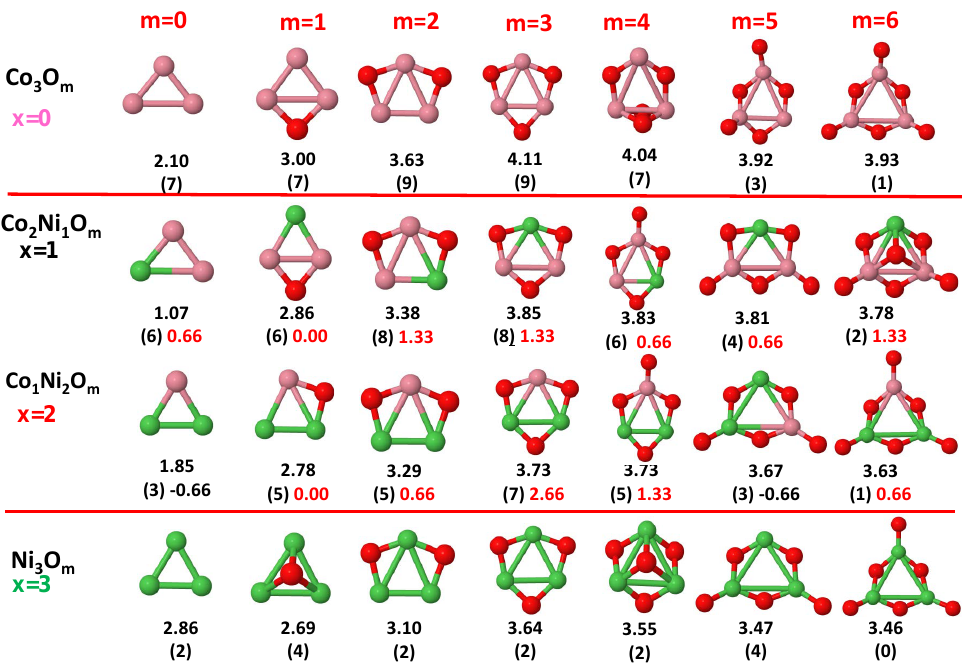
Figure 5. Putative global minimum structures of Co 3 − x Ni x O m , x = 0–2, m = 1–6. Numbers below structures are the binding energy per atom (in eV), numbers in parentheses are the magnetic moment (in µ B ) and the third number (when present) is the excess magnetic moment (in µ B ) defined in Equation (2). Co atoms in pink color, Ni atoms in green and oxygen atoms in red.